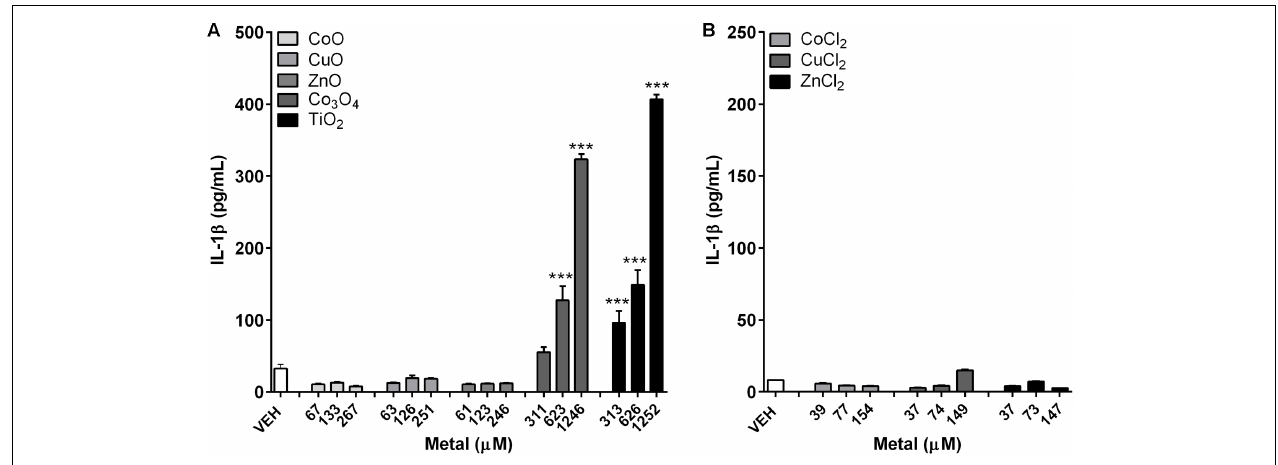
FIGURE 3 | Concentrations of IL-1 β in differentiated THP-1 cells after treatment with metal-oxide NPs or metal chlorides. (A) Fast-dissolving NPs showed no significant increase, while biopersistent Co 3 O 4 and TiO 2 NPs showed significant increase in a dose-dependent manner. (B) Metal chlorides showed no significant increase. The selected doses were 5, 10, and 20 µ g/mL for fast-dissolving NPs and metal chlorides; and 25, 50, and 100 µ g/mL for biopersistent control NPs (Co 3 O 4 and TiO 2 ). Note that the doses were converted into molar concentrations. Values are mean ± SEM from eight independent experiments. ∗∗∗ p < 0.001 vs. vehicle control (VEH).